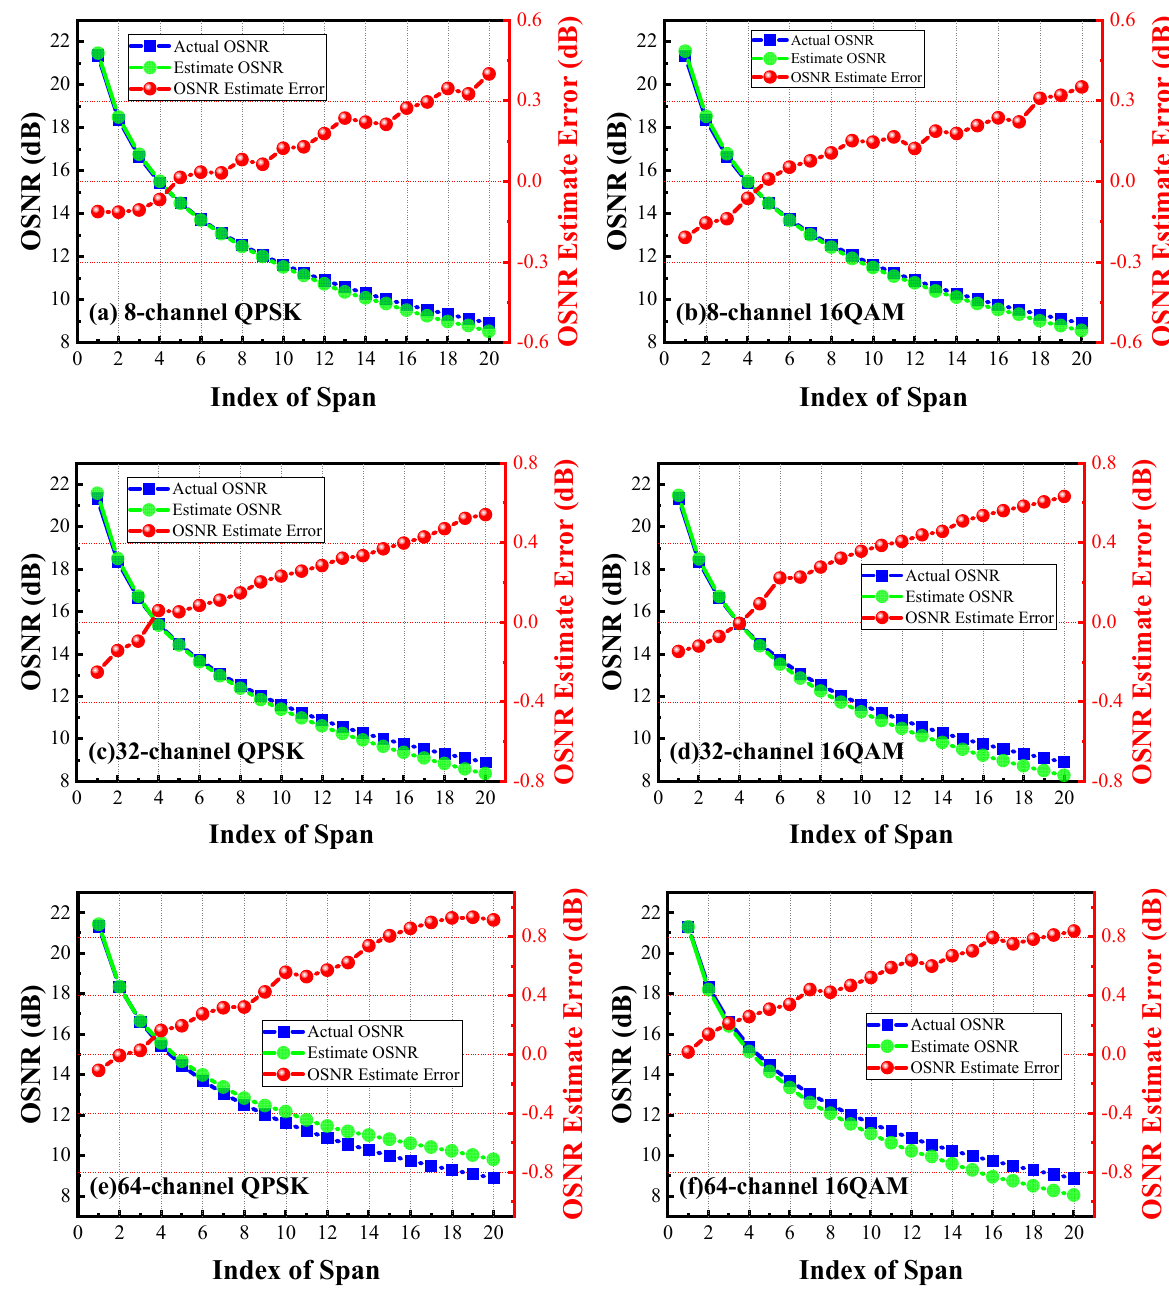
Figure 7. Result of OSNR estimation and corresponding error under 100 km equal-length span in ( a ) 8-channel QPSK, ( b ) 8-channel 16QAM, ( c ) 32-channel QPSK, ( d ) 32-channel 16QAM systems, ( e ) 64-channel QPSK systems, and ( f ) 64-channel 16QAM system.